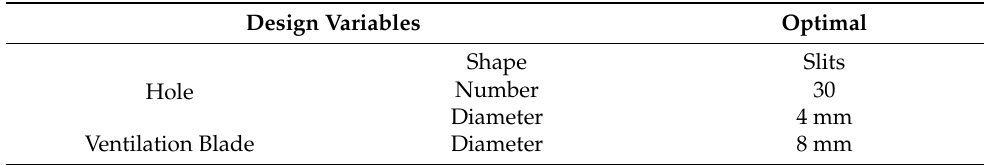
Table 6. Optimal values of the design variables.